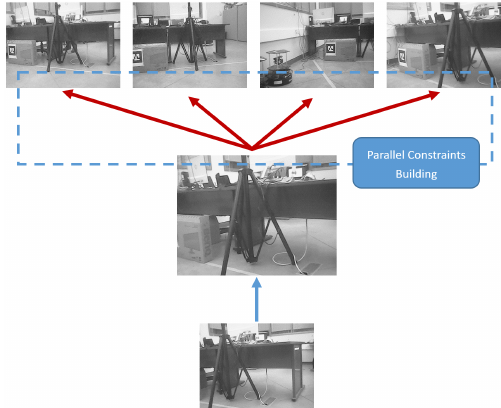
Figure 5. Illustration of parallel design of new keyframe (middle image); besides a constraint from the last keyframe (blue arrow), multiple loop-closure constraints to existing reference frames (red arrows) are built in